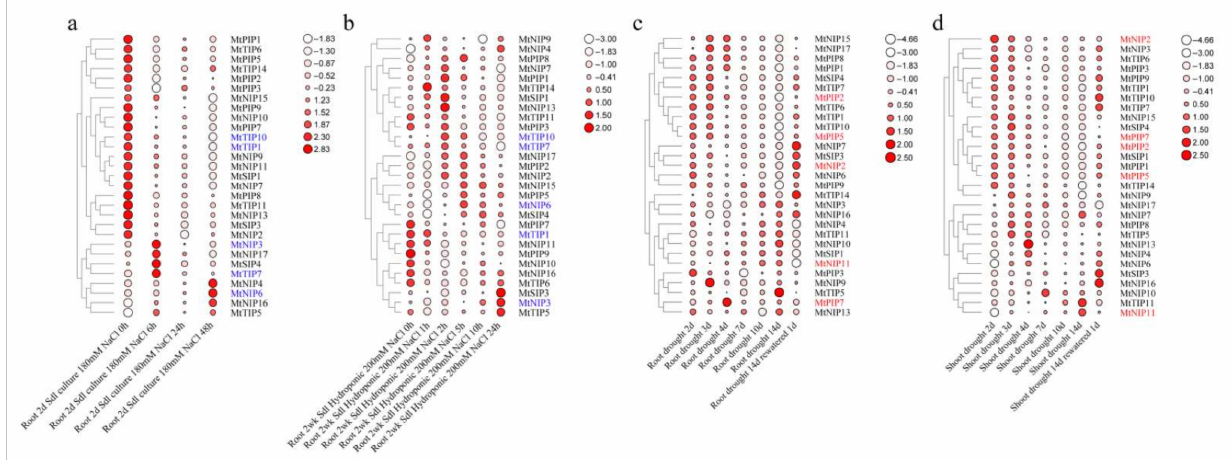
Figure 5. Expression profiles of MtAQP genes under different treatments at different time points were retrieved from the M. truncatula gene expression atlas with multiple GeneChip ® data. The color of circles from white to red indicates the expression level from low to high after normalization. ( a ) Expression profiles of MtAQP genes in roots under 180 mM NaCl treatment at 0, 6, 24 and 48 h; ( b ) Expression profiles of MtAQP genes in roots under 200 mM NaCl treatment at 0, 1, 2, 5, 10 and 24 h; ( c ) Expression profiles of MtAQP genes in roots under drought treatment at 2, 3, 4, 7, 10, 14 d and rewater 1d after 14 d drought treatment; ( d ) Expression profiles of MtAQP genes in shoots under drought treatment at 2, 3, 4, 7, 10, 14 d and rewater 1 d after 14 d drought